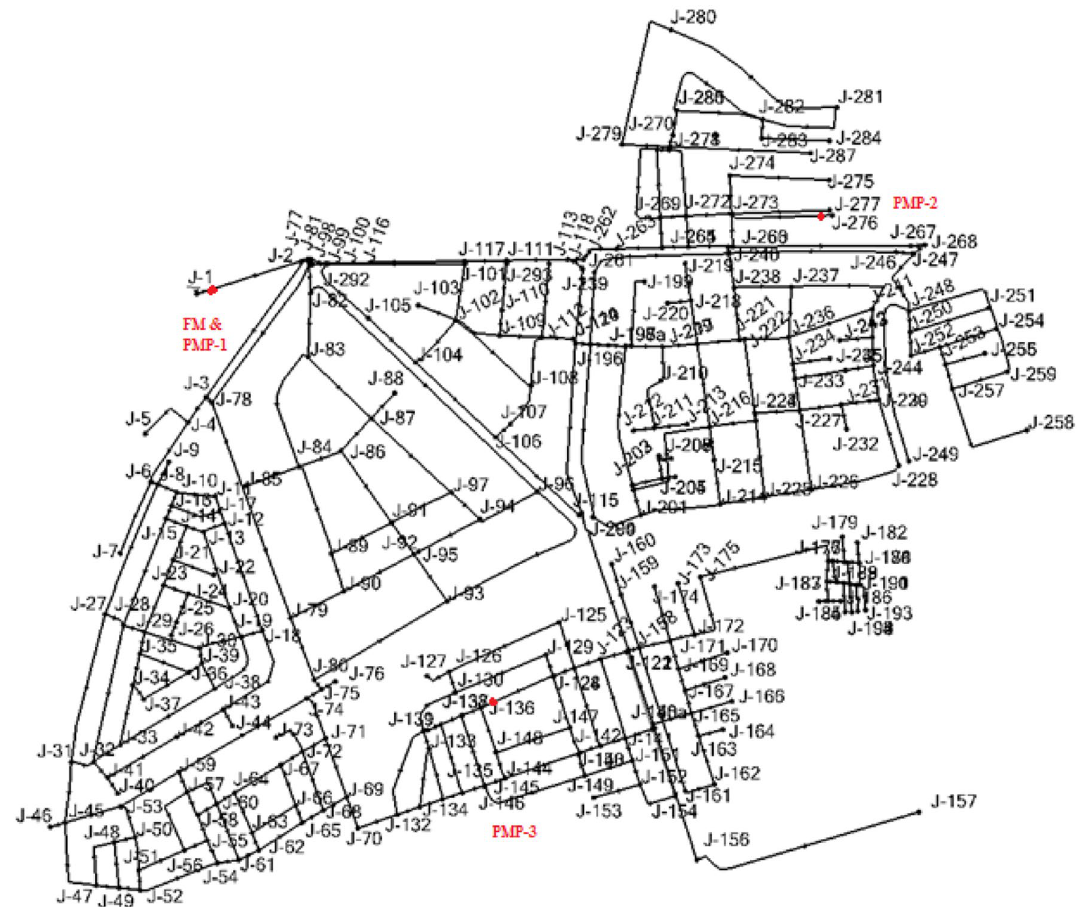
Fig. 1 Ramnagar GSR operational water distribution